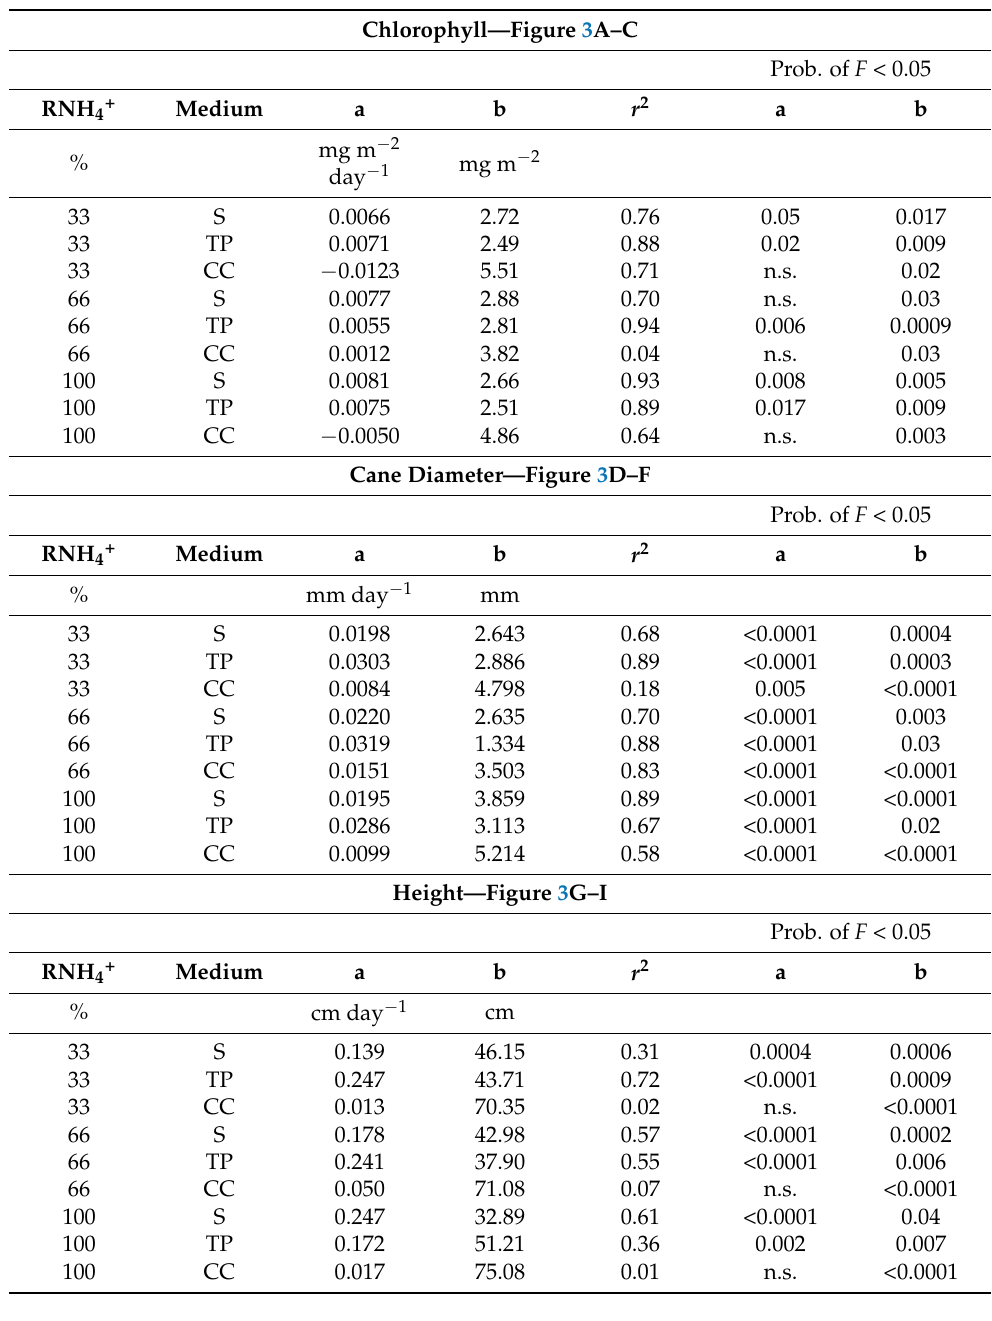
Table 5. The best-fit parameters of Equation (3) for best-fit curves of chlorophyll concentration, cane diameter and plant height as functions of time (data shown in Figure 3); r 2 = coefficient of determination. a and b are constants that were determined by best-fit linear regression (JMP 14).